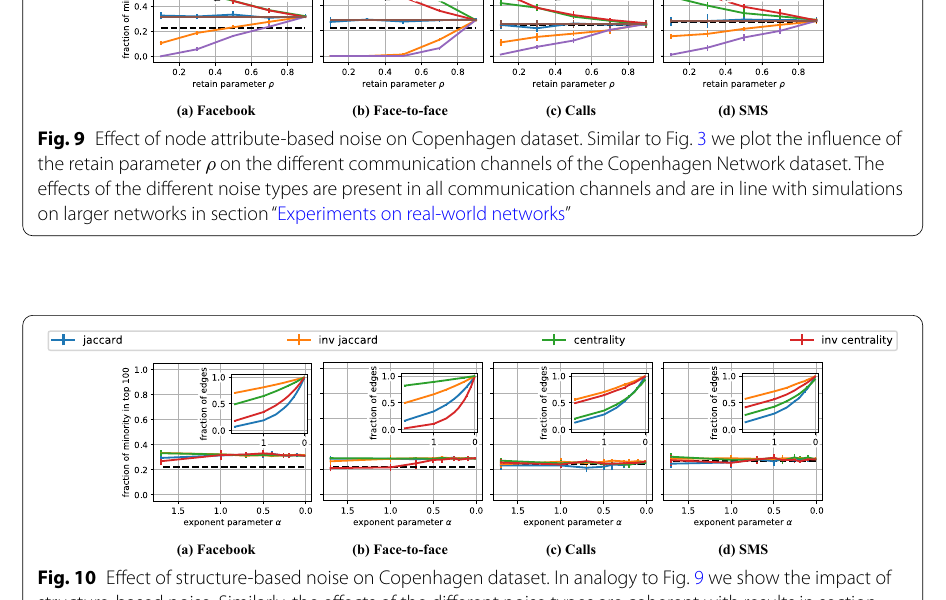
Fig. 10 Effect of structure-based noise on Copenhagen dataset. In analogy to Fig. 9 we show the impact